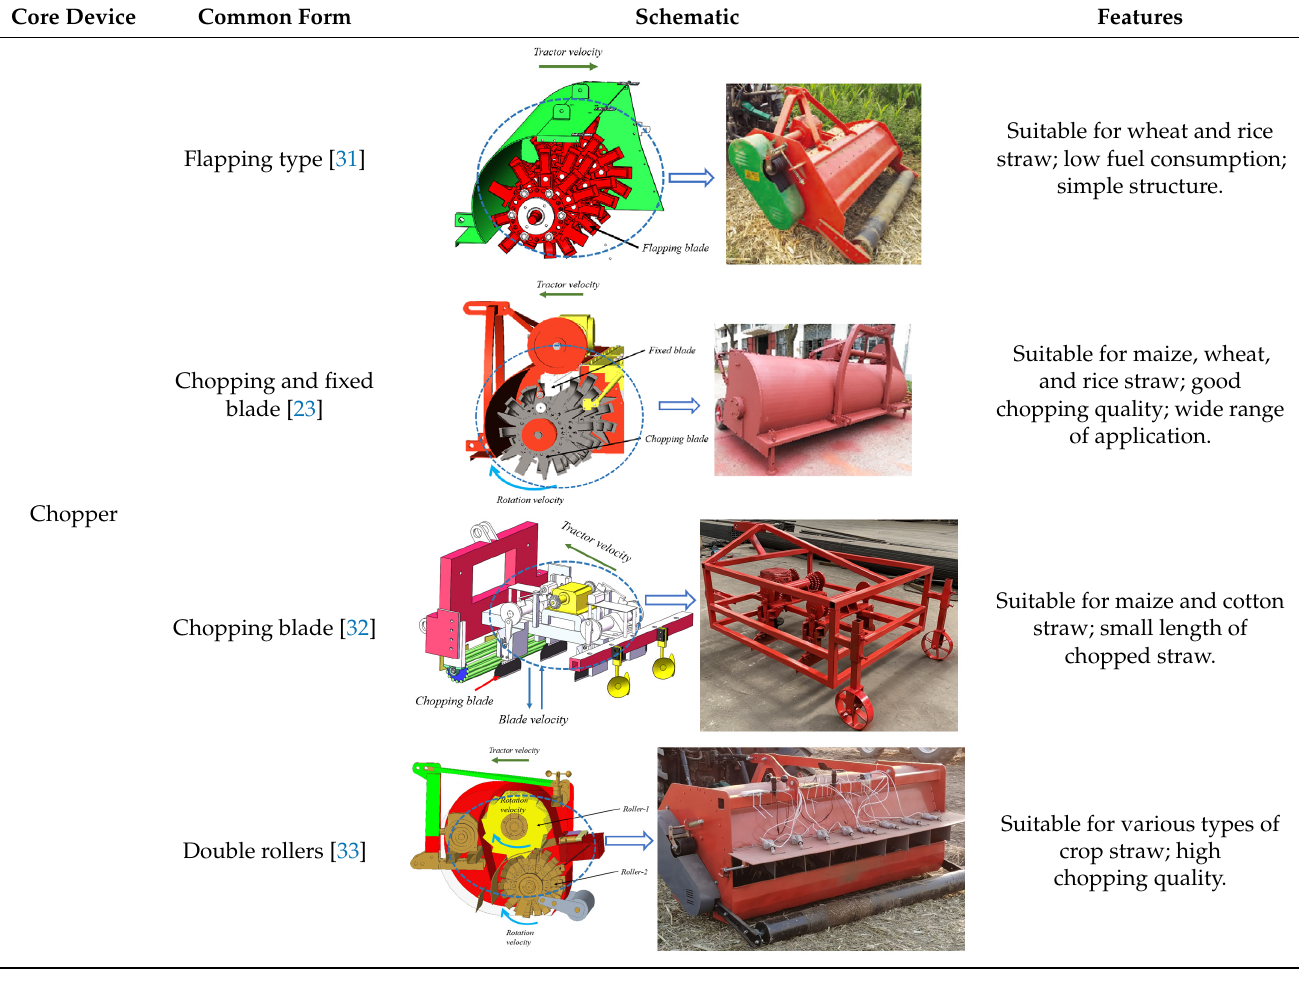
Table 4. Common forms of the